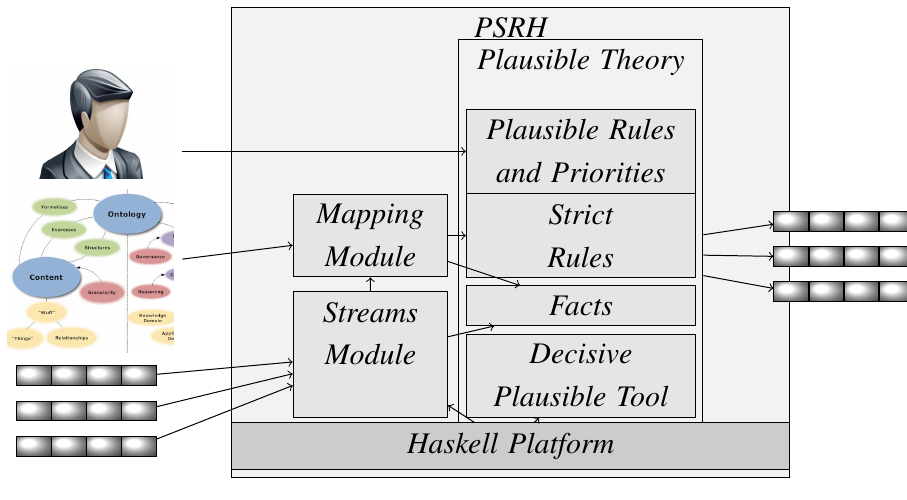
Figure 2. The architecture of the PSRH (Plausible Stream Reasoning in